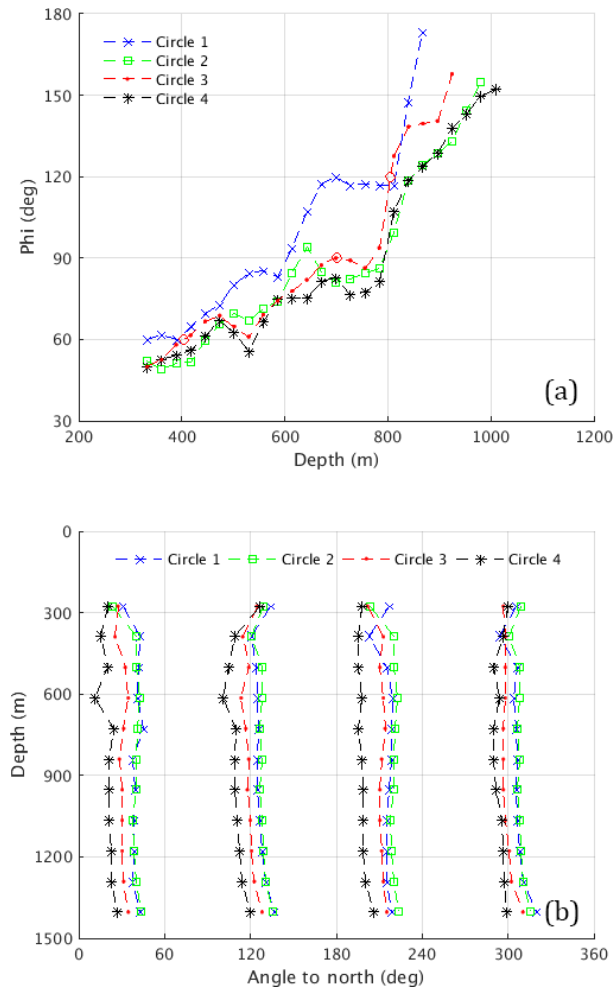
Figure 6. (a) Estimated birefringence phase shift as a function of depth; (b) HV power minimum locations. The ice divide is parallel to 119 . 3 ◦ and 299 . 3 ◦ in this